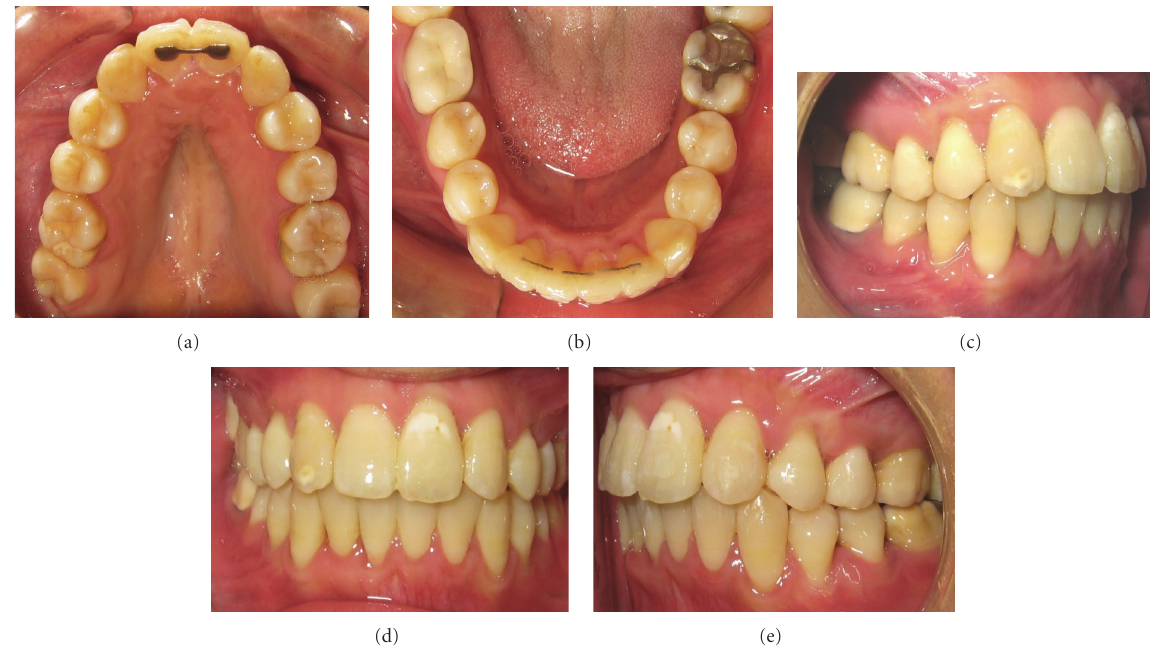
Figure 9: Intraoral photographs 32 weeks after corticotomy.